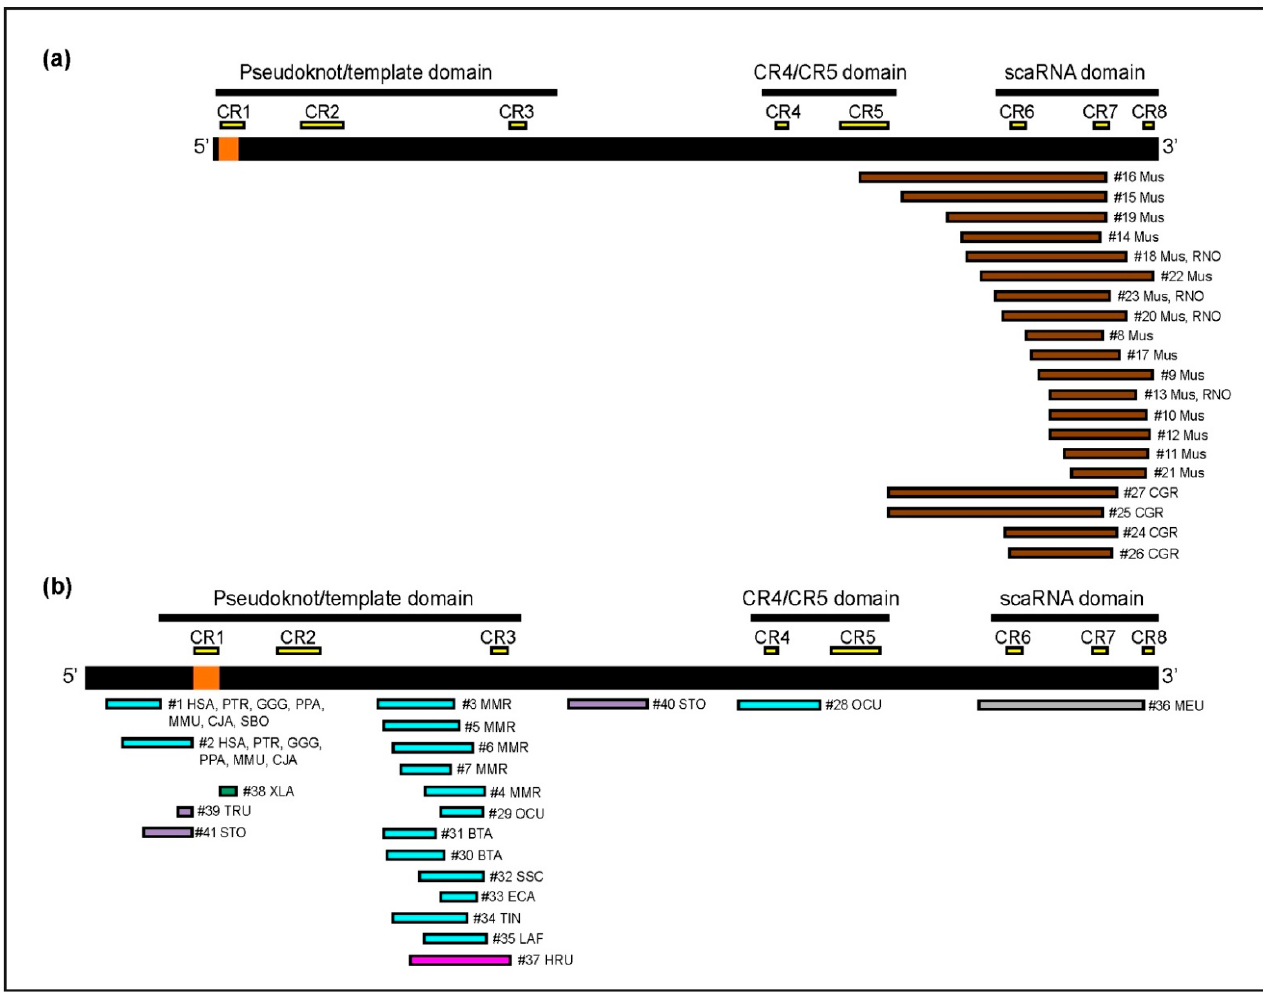
Figure 3. Sketch showing the portion of TERC included in each TERC-ITS. ( a ) The mouse TERC sequence is shown on top as a thick black line. Rodent TERC-like sequences are indicated as brown lines. ( b ) The human TERC sequence is shown on top. TERC-like sequences from non-rodent mammals are indicated as light blue lines, from marsupials as grey lines, from amphibians as dark green lines, from birds as pink lines, and from fish and shark as violet lines. On the TERC sequences, the position of the telomeric repeat template is marked in orange (CR1). The template region, which is retrotranscribed, by definition, at all loci, is not comprised in the colored lines.